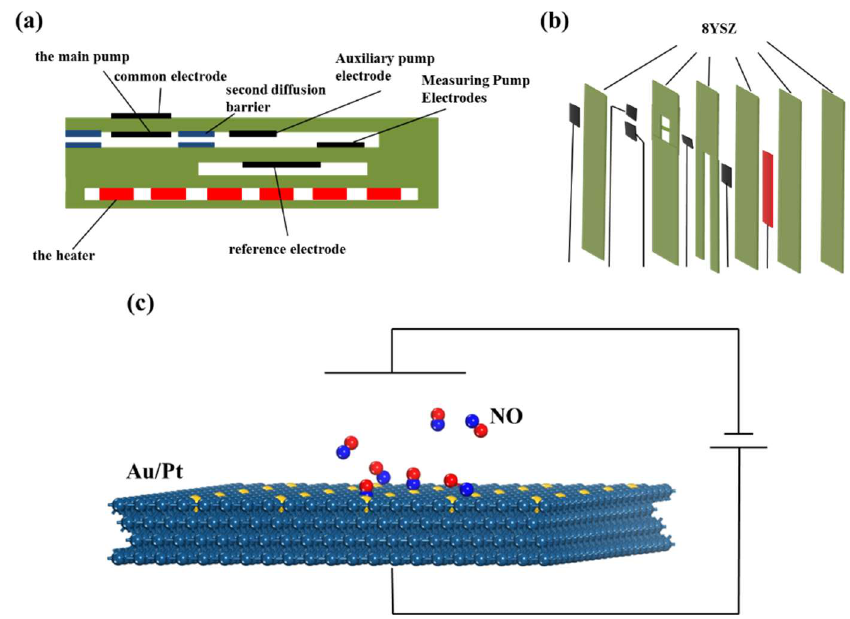
Figure 1. ( a , b ) Schematic diagram of the structure and ( c ) the molecular simulation structure of the nitrogen oxide sensor.